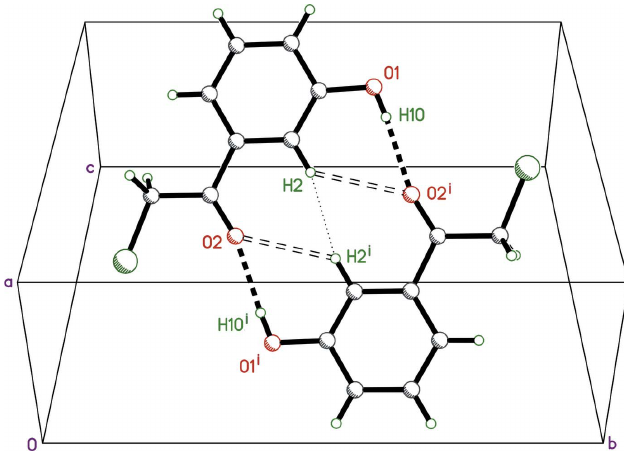
Figure 2 A partial packing plot showing the main supramolecular motif in I : a hydrogen-bonded dimer between inversion-related [symmetry code: (i) (cid:3) x + 1, (cid:3) y + 1, (cid:3) z + 1] molecules. Strong O—H (cid:2)(cid:2)(cid:2) O hydrogen bonds are shown as thick dashed lines, weaker C—H (cid:2)(cid:2)(cid:2) O interactions as open dashed lines, and an unfavourable, forced close contact between hydrogen atoms as a dotted line.